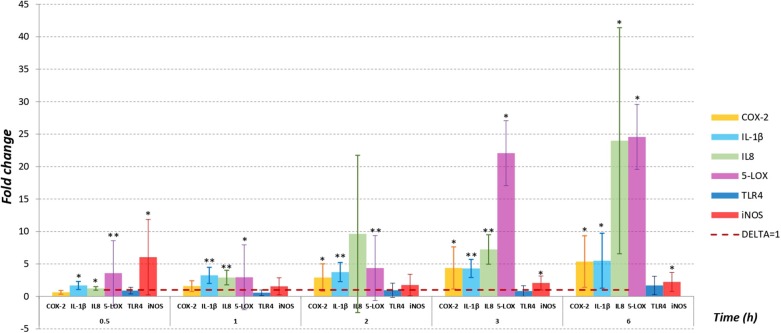
PMNs were infected with Mmm Caprivi at MOI = 100. RT-qPCR was applied to examine the mRNA levels and fold changes were calculated by 2−(ΔΔCT) method as compared to unexposed control cells. Endogenous β-actin mRNA level was used for normalization. Fold changes were expressed as mean ± SD from three sets of independent experiments. No mRNA expression for TNFα was recorded in exposed PMNs and in control cells. No signals were appreciated at 18 h time sampling for all targeting genes. *P < 0.05; **P < 0.01.